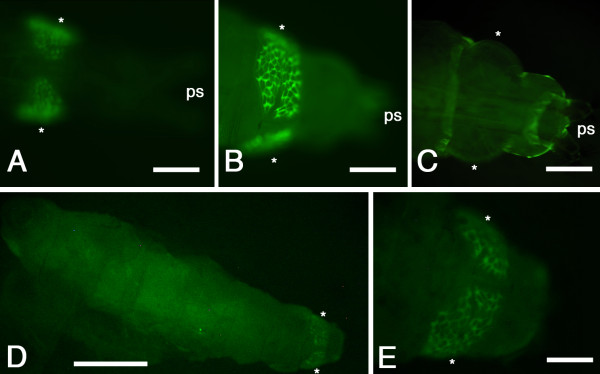
EGFP expression in transgenic larvae. Larvae are from line 34.6 (A, B), line 17.1 (D,E) or non-transgenic (C). In both transgenic lines EGFP fluorescence was restricted to the posterior-most segments of the larva. Asterisks denote anal pads and ps denotes posterior spiracles. (A) Posterior end of a first instar larva showing EGFP expression in the anal pads. Note the position of the posterior spiracles. (B) Posterior end of a third instar larva showing strong EGFP fluorescence in mature anal pads. (C) Posterior end of a non-transgenic third instar larva. A degree of autofluorescence is visible in the cuticle but not in the anal pads. (D) Full length third instar larva showing EGFP expression at the posterior end. Autofluorescence is visible in the gut. (E) High power view of anal pad EGFP expression of the larva shown in (D). Scale bar in A = 100 μm; in B, C, and E = 200 μm; in D = 1 mm.